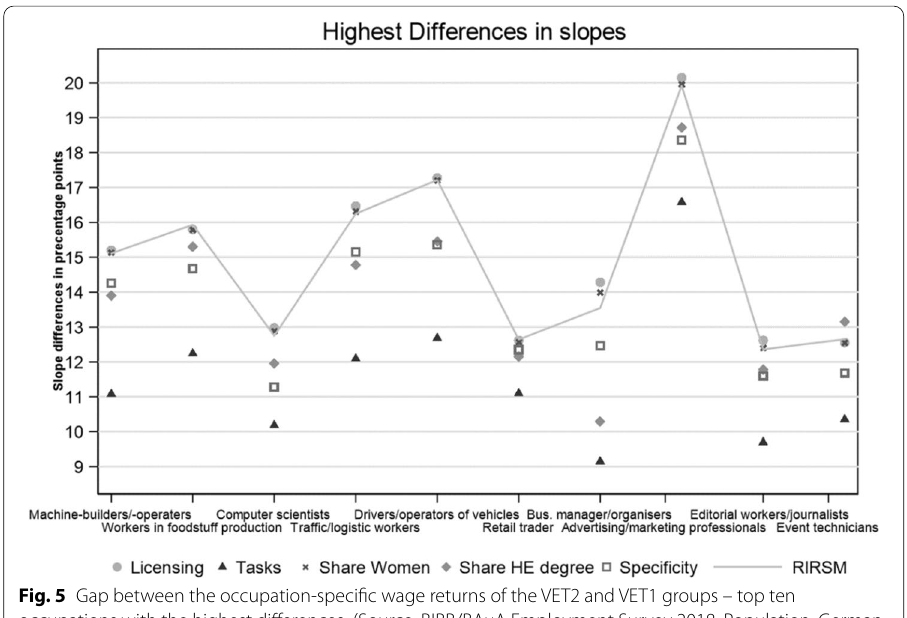
Fig. 5 Gap between the occupation-specific wage returns of the VET2 and VET1 groups – top ten occupations with the highest differences (Source: BIBB/BAuA Employment Survey 2018. Population: German